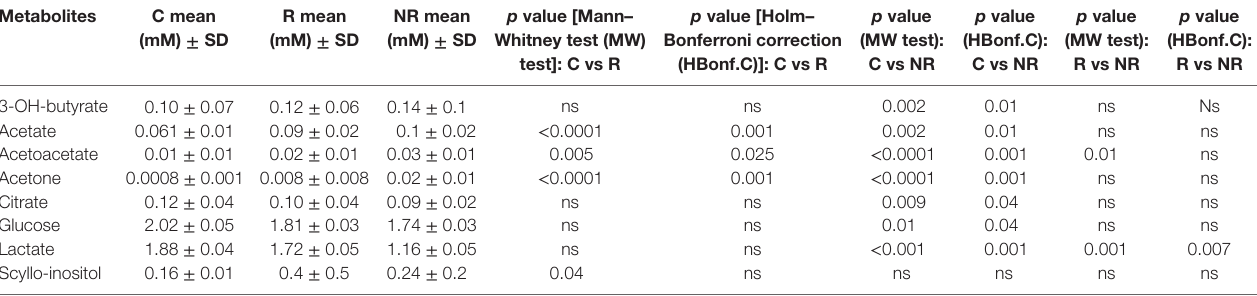
TaBle 4 | Metabolites significant altered among the classes control (C), responder (R), and non-responder (NR).